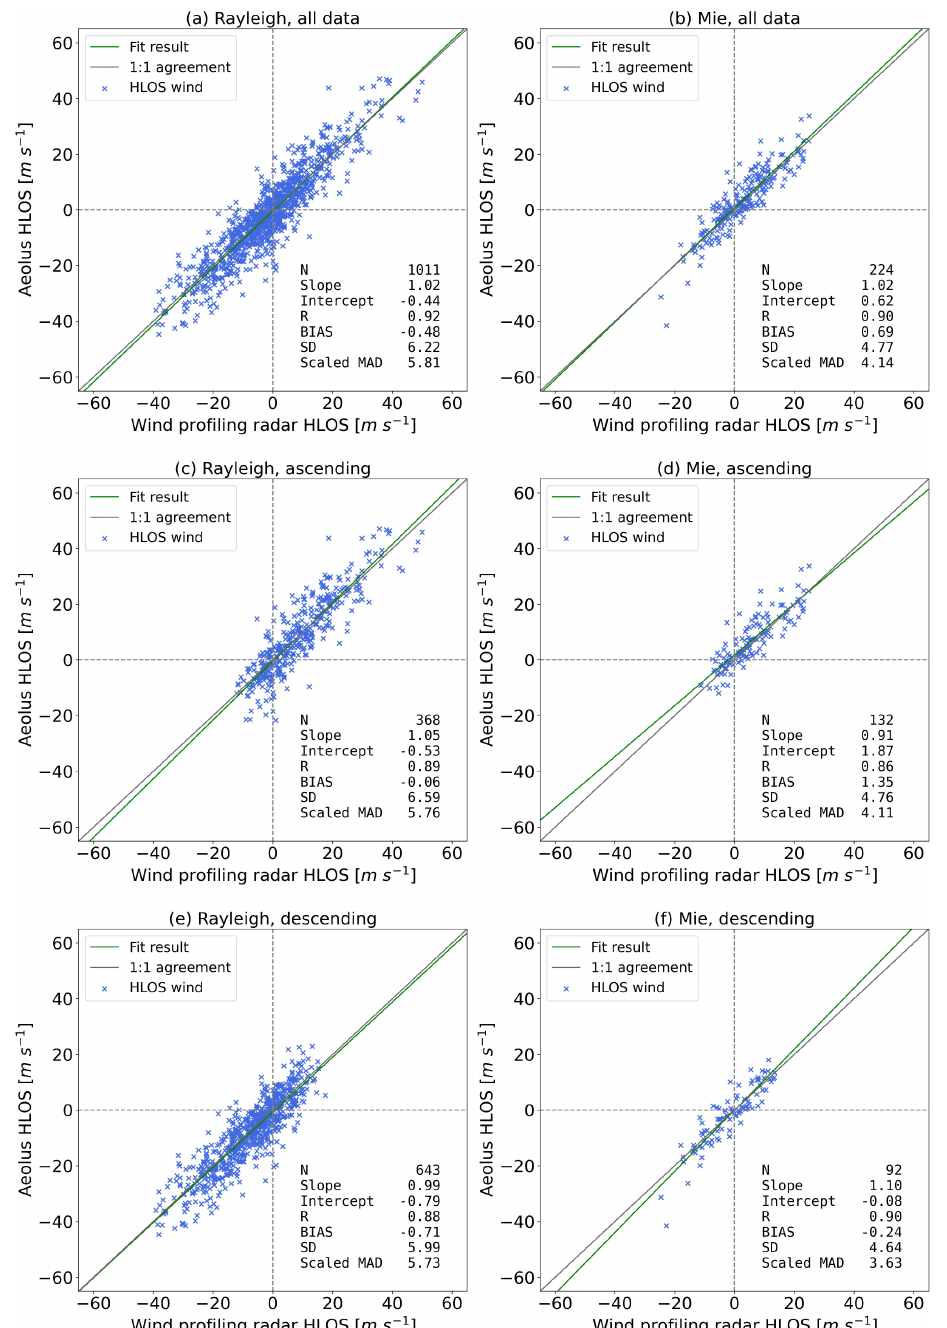
Figure 4. Scatter plots of Aeolus HLOS winds against WPR HLOS winds for all data, ascending orbits, and descending orbits. Panels (a) , (c) , and (e) are for the Rayleigh-clear winds, and (b) , (d) , and (f) are for the Mie-cloudy winds. Green and grey lines indicate the fitted regression result and 1:1 agreement,